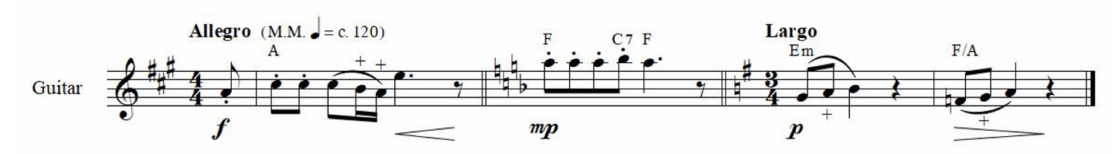
Figure 5. Modified scores for sound coding saturated (left), light (middle), and dark (right) colors played with a guitar (same for piano and